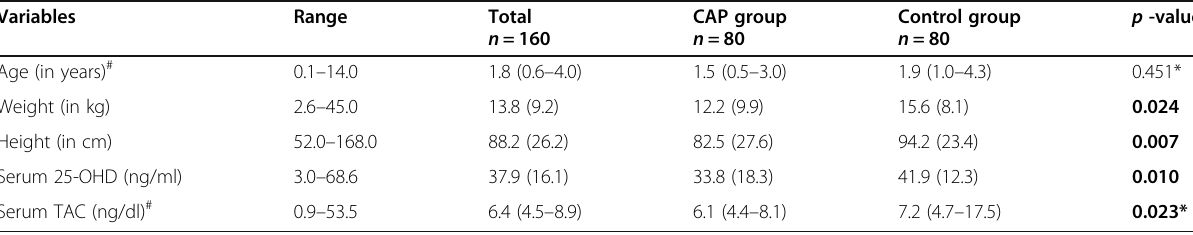
Table 2 Anthropometrics, serum vitamin D and total antioxidant capacity levels in the study participants